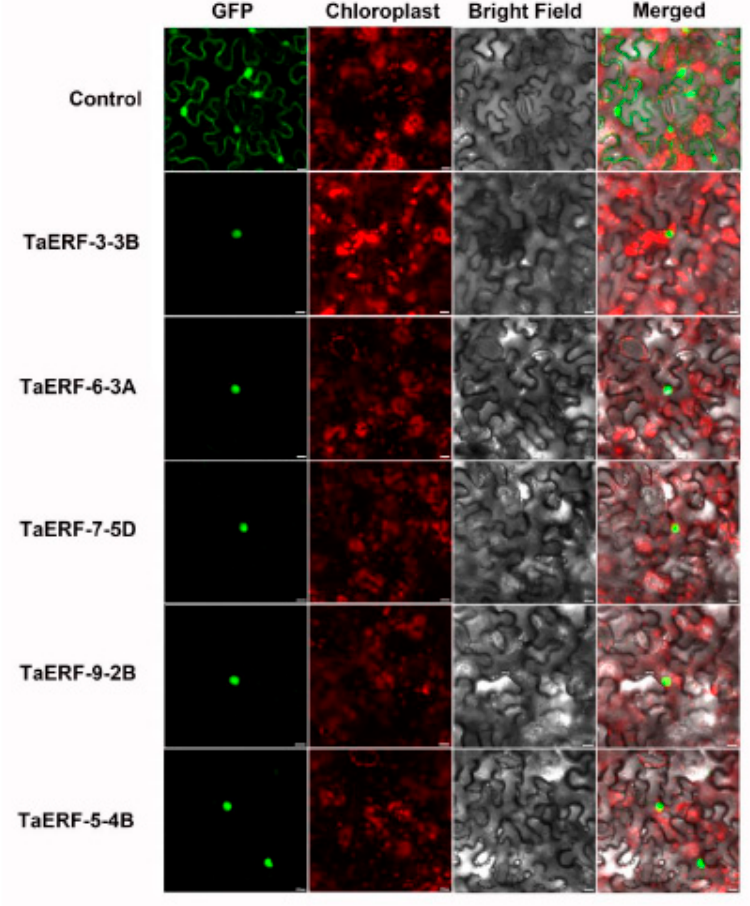
Figure 6. Subcellular localization of five TaAP2/ERF proteins as GFP fusions. Recombinant CaMV35S:TaAP2/ERF-GFP vector and control CaMV35S-GFP vector were transiently expressed in tobacco cells.